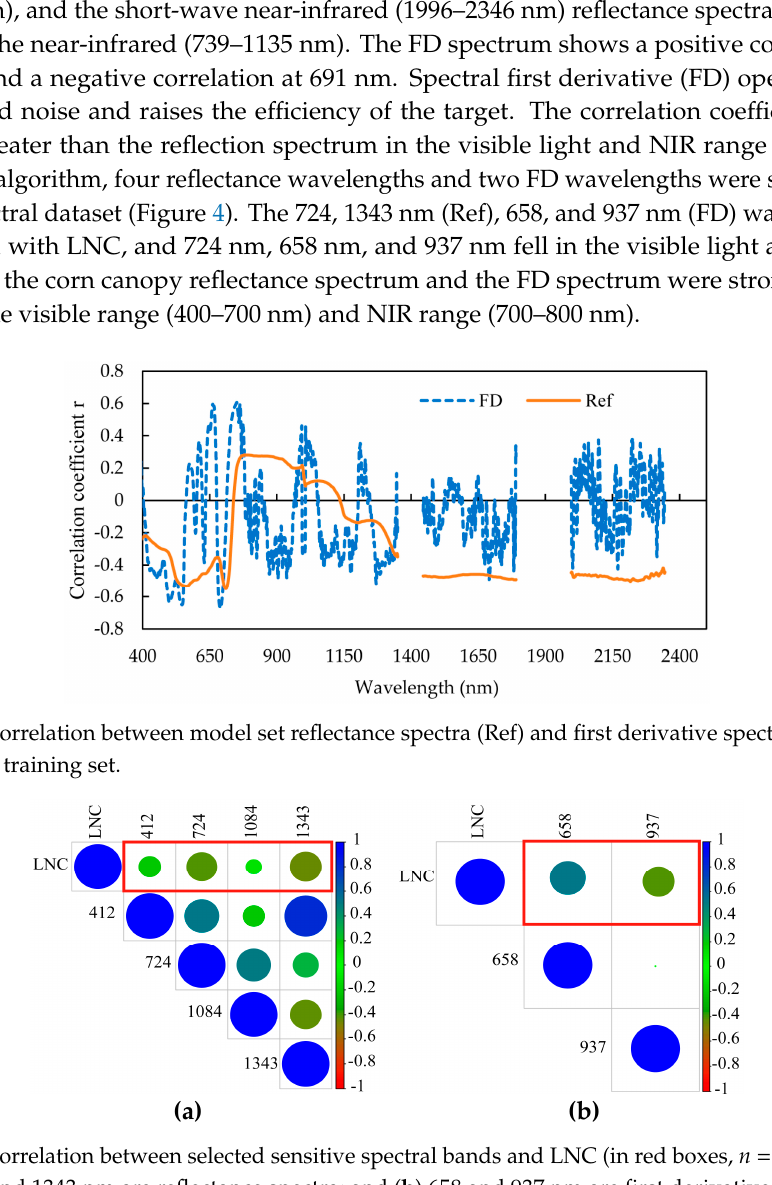
Figure 4. Correlation between selected sensitive spectral bands and LNC (in red boxes, n = 48). ( a ) 412, 724, 1084, and 1343 nm are reflectance spectra; and ( b ) 658 and 937 nm are first derivative spectra.